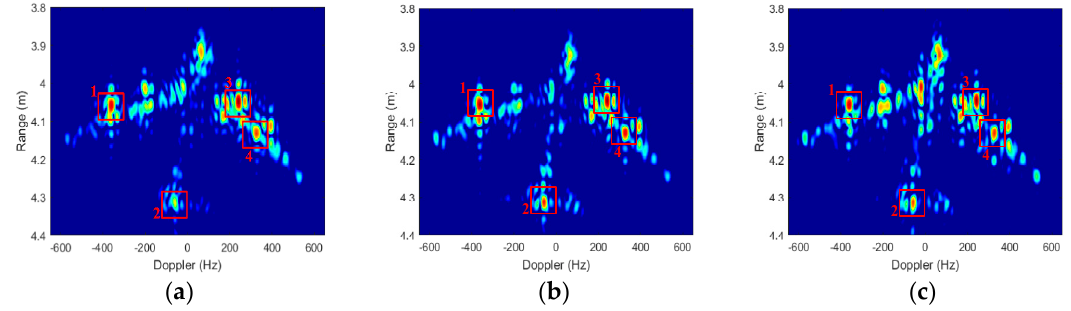
Figure 10. ISAR imaging results of A380 model with small rotation angle. ( a ) Antenna A; ( b ) Antenna B; ( c ) Antenna C. Table 2. Doppler frequencies and coordinates of four dominant scatterers.